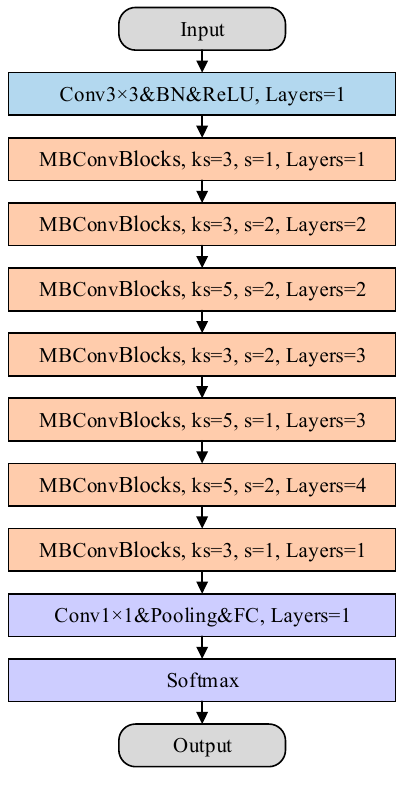
Figure 6. Structure of EfficientNet-B0.